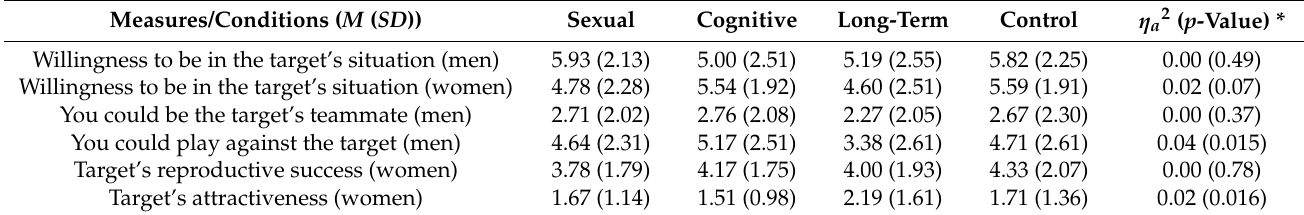
Table 2. Means and standards deviations of the different dependent variables across the different conditions. Measures/Conditions ( M ( SD )) Sexual Cognitive Long-Term Control η a 2 ( p -Value) * Willingness to be in the target’s situation